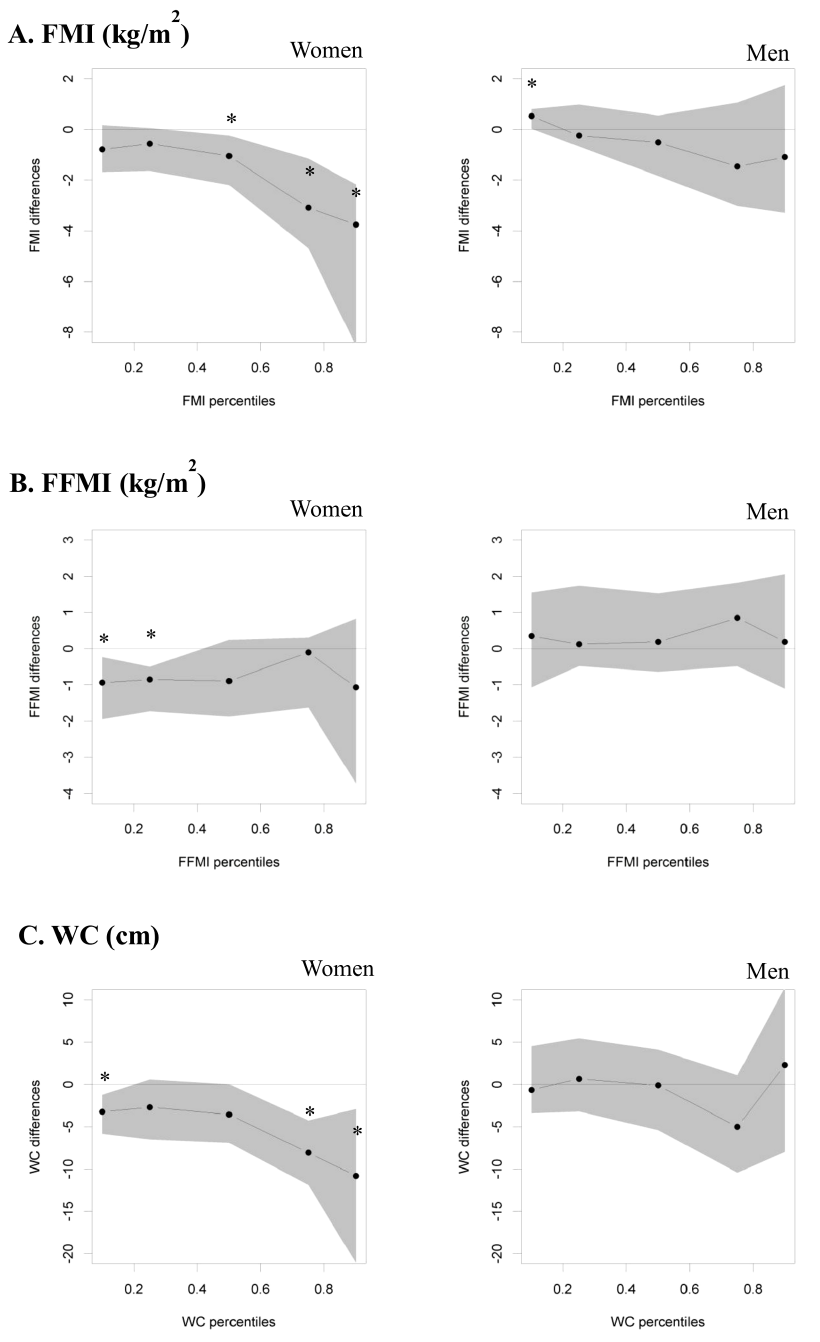
Figure 2. Body composition measures in young adulthood according to breastfeeding duration in multivariable quantile regression models. Displayed are point estimates (95% CI) for FMI (A), FFMI (B) and WC (C) differences between women and men breastfed for a long duration (i.e. . 17 weeks) vs. those not breastfed (i.e. # 2 weeks) for specific percentiles (10 th , 25 th , 50 th , 75 th and 90 th percentiles) in multivariable quantile regression models. Models included age in adulthood, maternal overweight (yes/no), paternal university degree (yes/no), firstborn status (yes/no), smoking in the household (yes/no) in the case of FMI and WC, and age in adulthood, maternal overweight (yes/no), paternal university degree (yes/no), birth weight and length (appropriate for gestational age yes/no), firstborn status (yes/no), smoking in the household (yes/no) in the case of FFMI. DONALD Study, n=232. * p , 0.05 DONALD, Dortmund Nutritional and Anthropometric Longitudinally Designed; FFMI, fat-free mass index; FMI, fat mass index; WC, waist circumference.